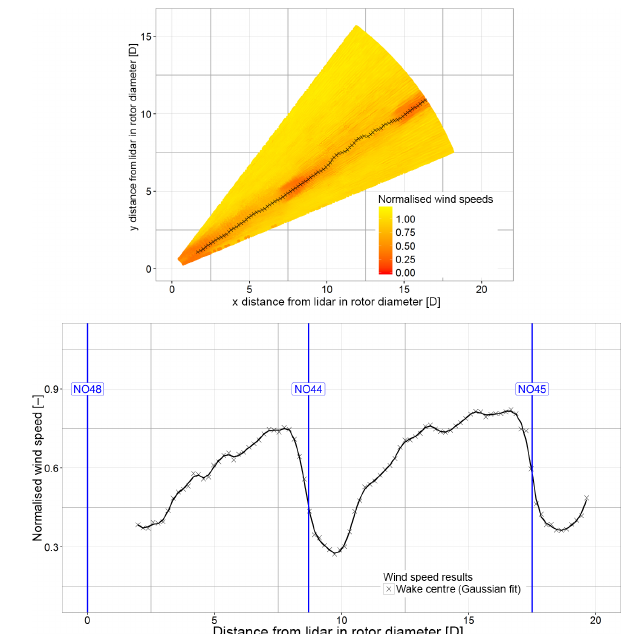
Figure 4. Upper plot: visualisation of the horizontal plan position indicator (PPI) scans downstream of NO48. Wind speed is nor- malised with the inflow wind speed measured at the met mast. The black crosses are the locations of the wind speed minima derived from a Gaussian fitting for each measurement distance. Bottom plot: normalised wind speed as a function of the distance in rotor di- ameters extracted from the top plot for the Gaussian-fitted minima (black